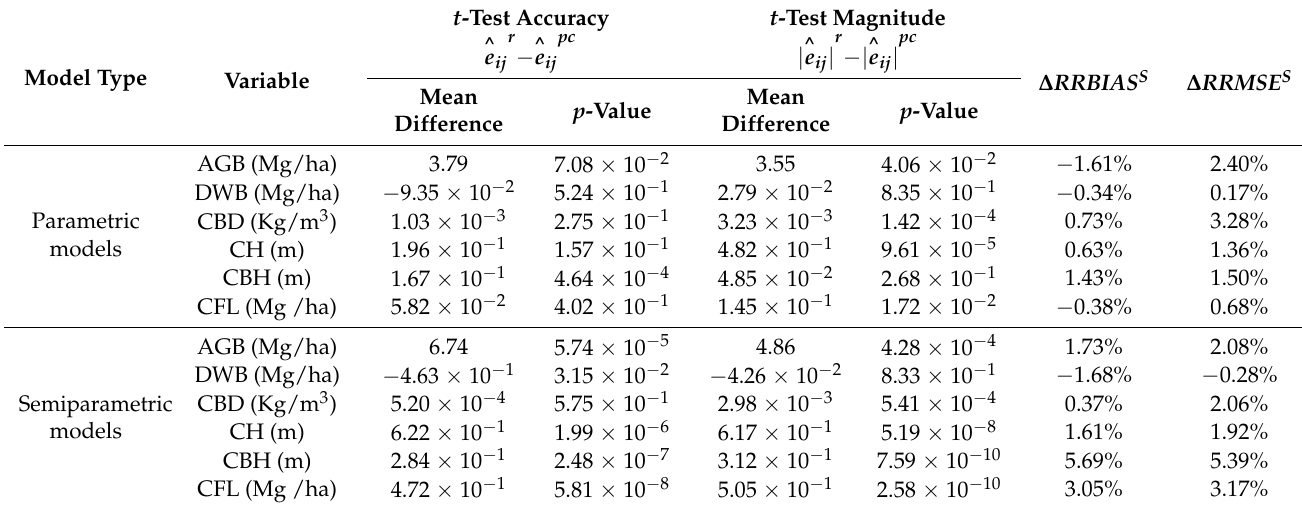
Table 5. Differences between models developed using point-cloud metrics and rasterized predictors. AGB, DWB, CBD, CH, CBH, and CFL respectively indicate aboveground biomass, downed woody biomass, canopy bulk density, canopy height, canopy base height, and canopy fuel load. Superscripts pc and r indicate error metrics for models point-cloud and rasterized predictors and the superscript s denote changes in RBIAS and RRMSE due to using a different source of ALS metrics.